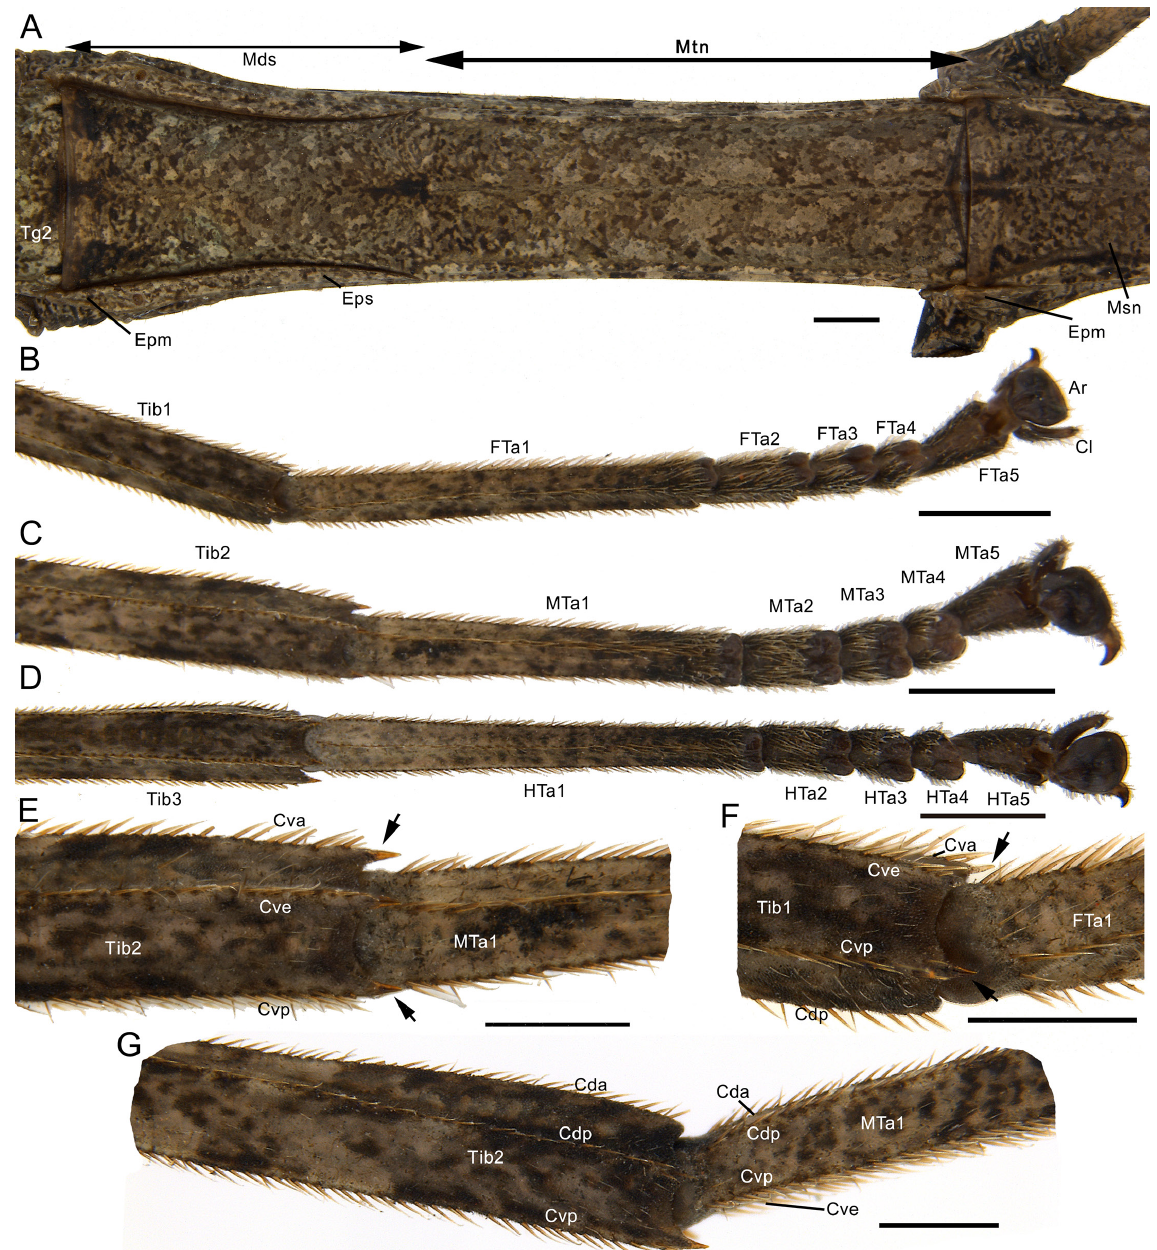
Fig. 49. Arumatia diamante Ghirotto gen. et sp. nov., holotype, ♀ (MZUSP V0650), thorax and leg morphology. A . Metathorax and median segment in dorsal view, arrows indicate the length of each segment. B . Left fore tarsus, ventral view. C . Left mid tarsus, ventral view. D . Left hind tarsus, ventral view. E . Detail of left mid tibia and tarsus, ventral view, arrows showing apical sessile spines. F . Detail of left fore tibia and tarsus, ventro-retrolateral view, arrows showing apical sessile spines. G . Detail of right mid tibia and tarsus, retrolateral view, arrow showing apical sessile spine. Abbreviations: Ar = arolium; Cda = dorsal anterior carina; Cdp = dorsal posterior carina; Cl = claw; Cva = ventral anterior carina; Cve = ventral carina; Cvp; ventral posterior carina; Epm = epimeron; Eps = episternum; FTa = fore tarsomere; HTa = hind tarsomere; Mds = median segment; Msn = mesonotum; MTa = mid tarsomere; Mtn = metanotum;Tg = tergum; Tib = tibia. Scale bars: A–D = 1 mm; E–G = 0.5